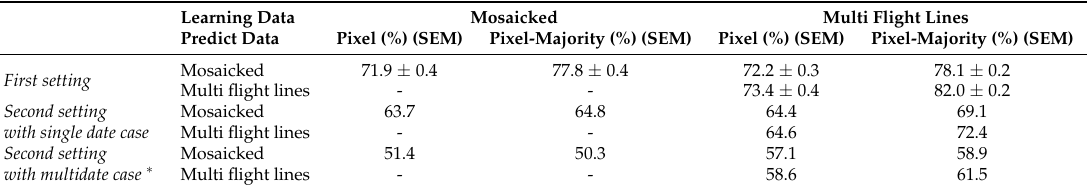
Table 7. Summary of the results comparing learning and prediction when multi-flight lines or mosaicked data were applied in the classification process. Standard error of the mean (SEM) is given at pixel and object level. Pixel and object express the accuracy rate. ∗ 60% of the data is not viewed